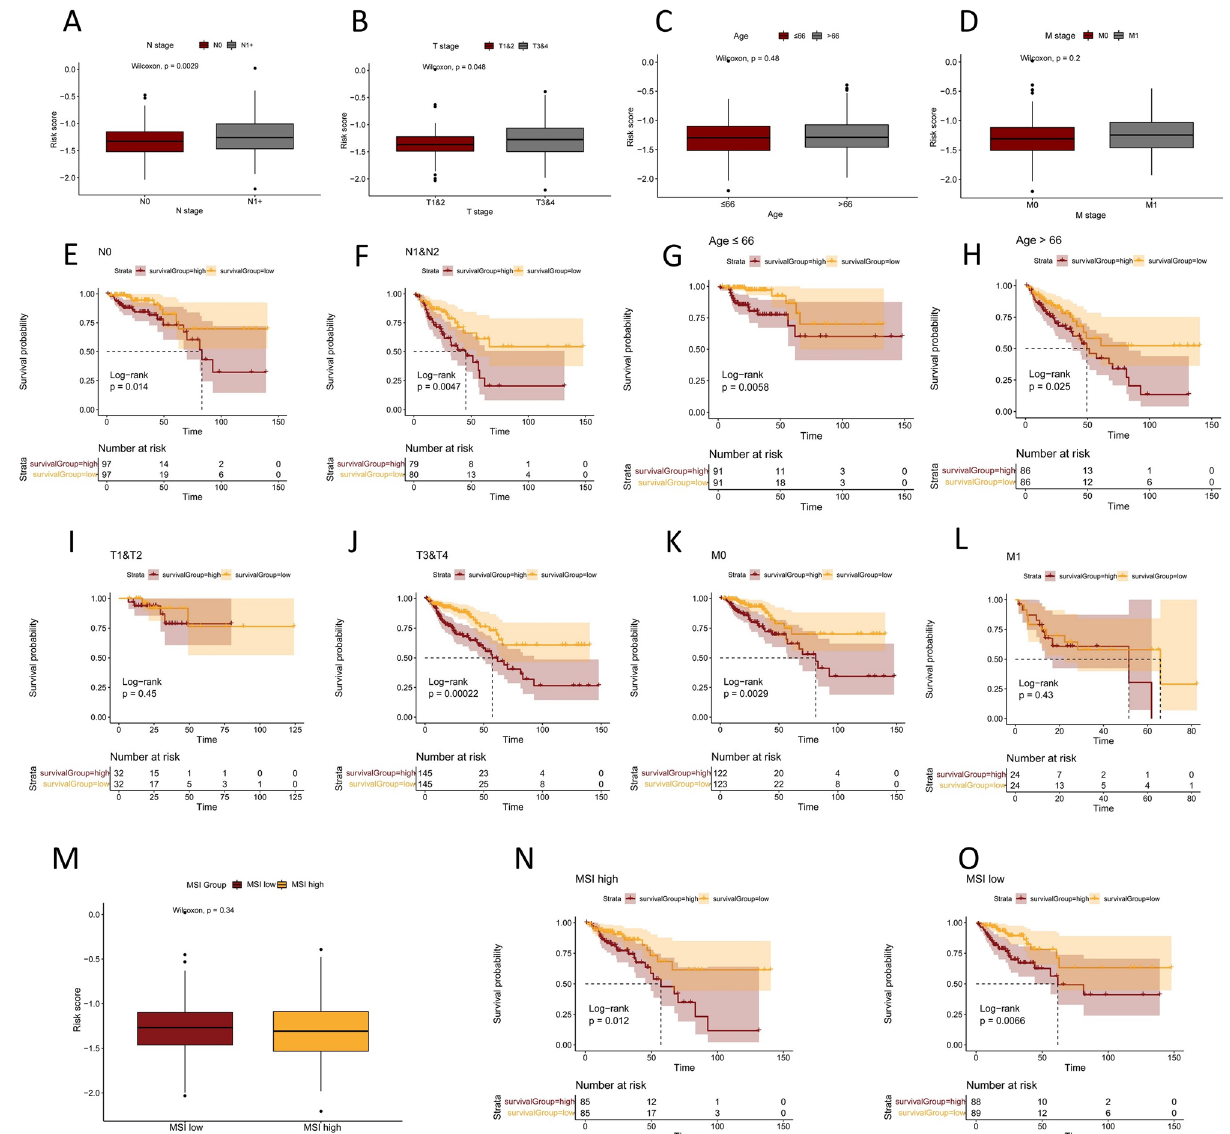
Figure 4. Association between pathologic characteristics and the prognostic signature in the TCGA cohort. ( A – D , M ) Distribution of the risk score in TCGA-CRC patients stratified by N stage, T stage, age, M stage